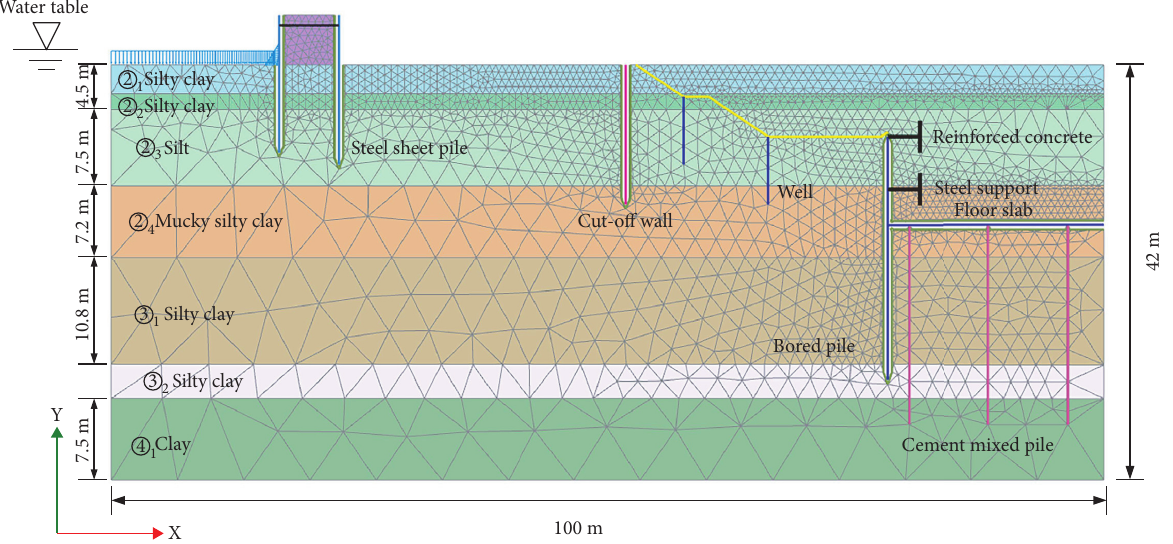
Figure 20: Two-dimensional finite element model and mesh generation.